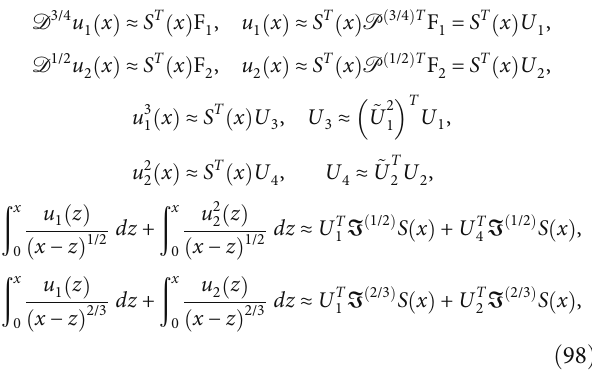
Figure 9: The graphs of the exact and approximate solutions and the absolute error function of ~ u